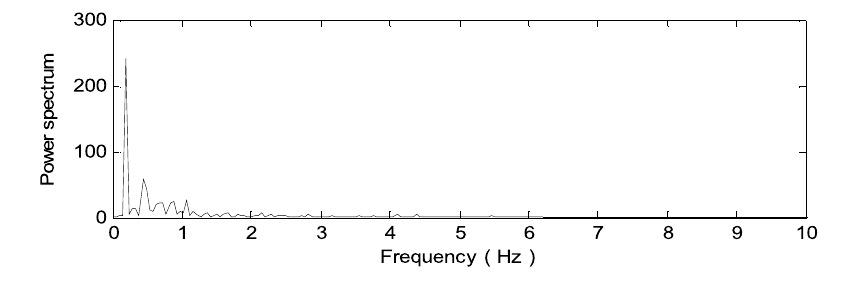
Fig. 4. Speed power spectrum of fl uctuating wind.